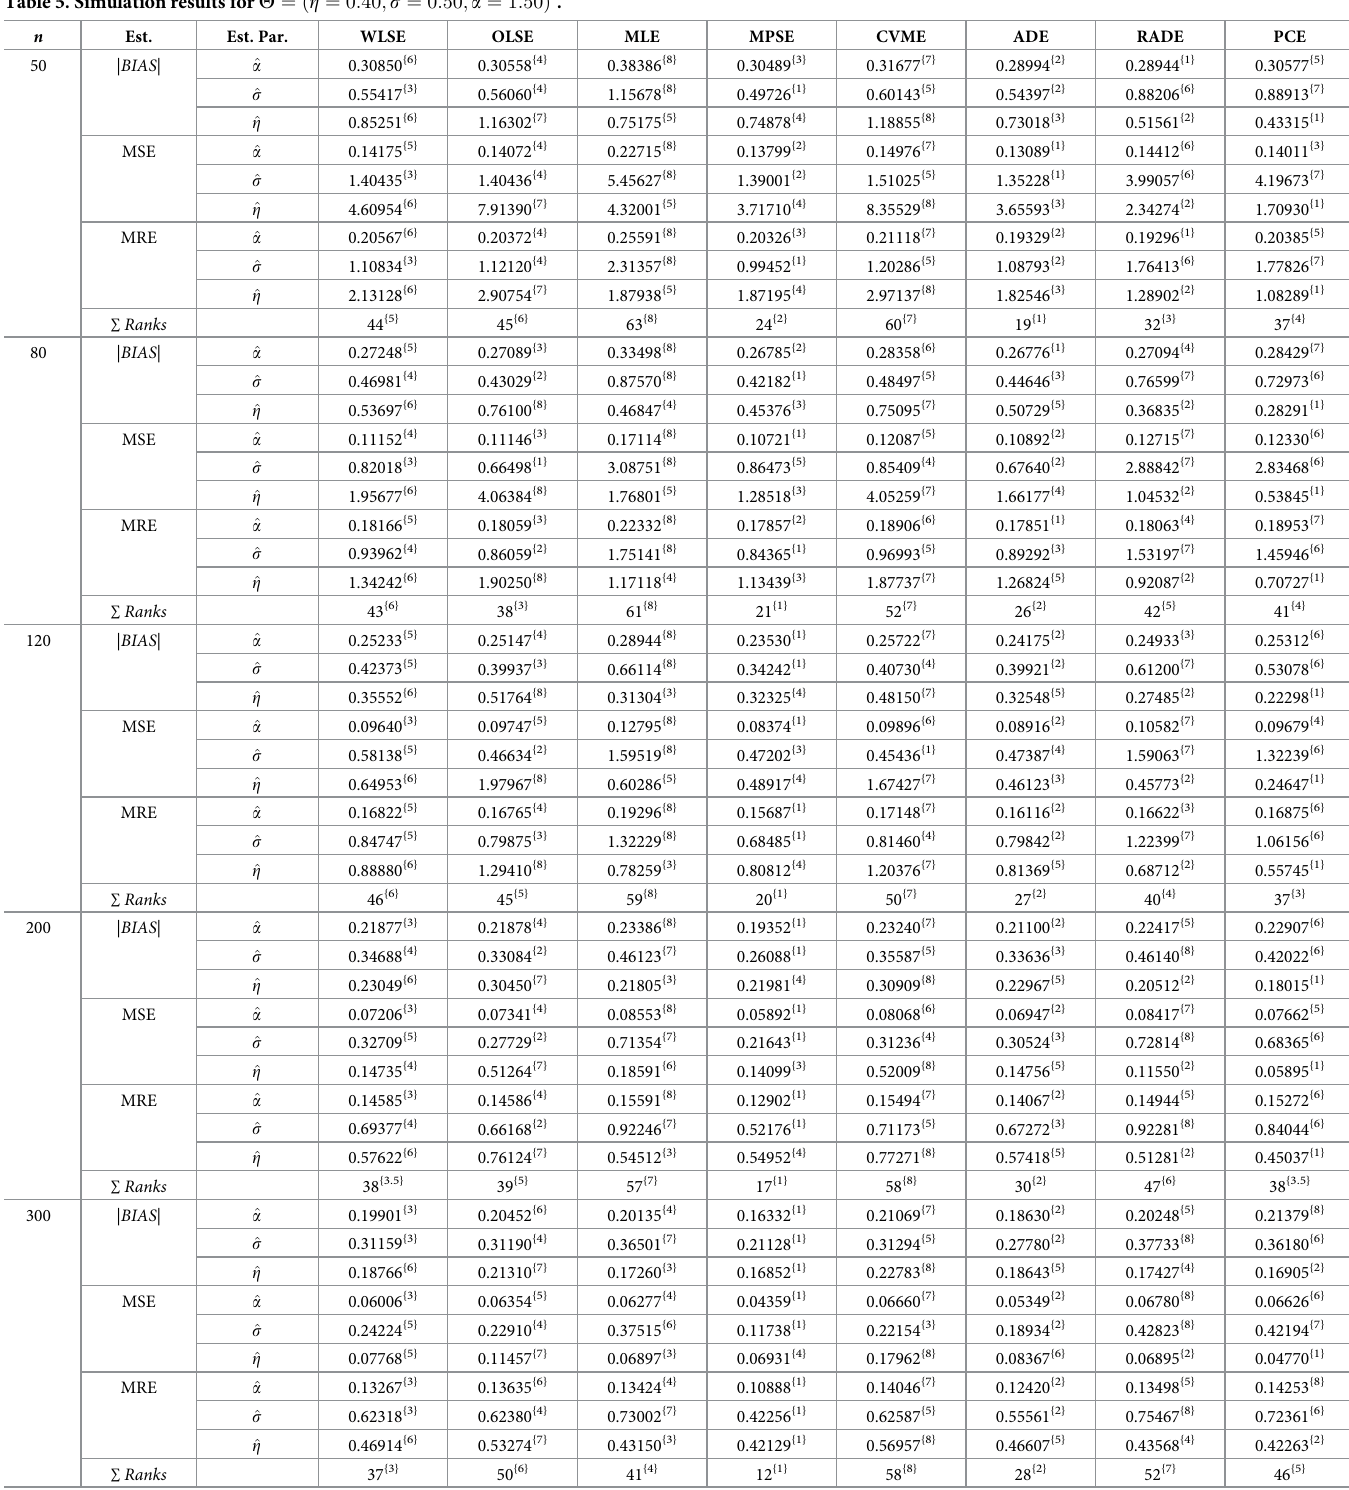
Table 5. Simulation results for Y ¼ ð Z ¼ 0 : 40 ; s ¼ 0 : 50 ; a ¼ 1 : 50 Þ ⊺